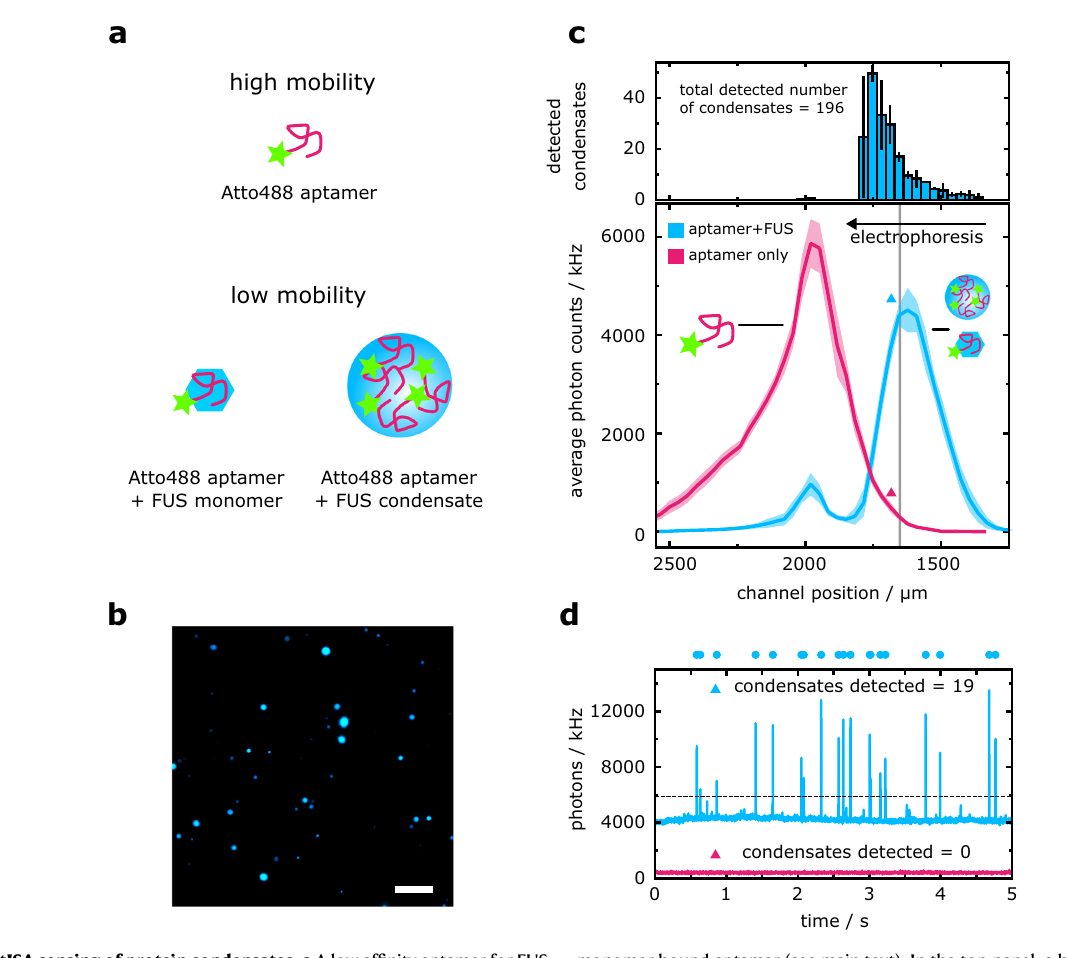
Fig. 7 | DigitISAsensing ofproteincondensates. a A low af fi nity aptamer for FUS protein can be found in three different states: unbound, with high electrophoretic mobility, bound to monomer protein, or partitioned into FUS condensates, the latter two exhibiting lower electrophoretic mobilities. b Fluorescently labelled GGUG aptamer is added to unlabeled FUS, resulting in the formation of biomole- cular condensates. Image was taken on a wide fi eld fl uorescence